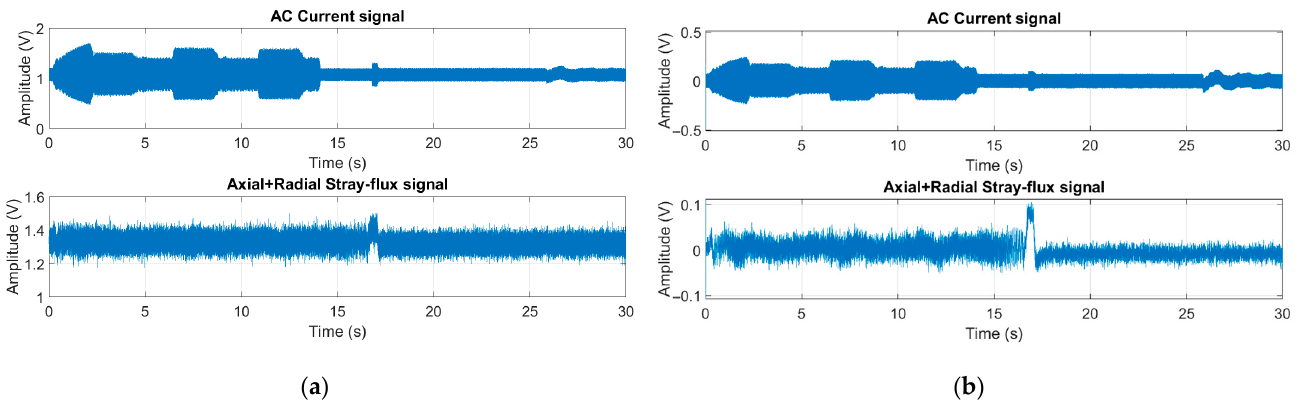
Figure 13. Current and stray flux signals measured during the 0.24 mm/rev test with the CT-f5 tool: ( a ) original signals; ( b ) conditioned signals.